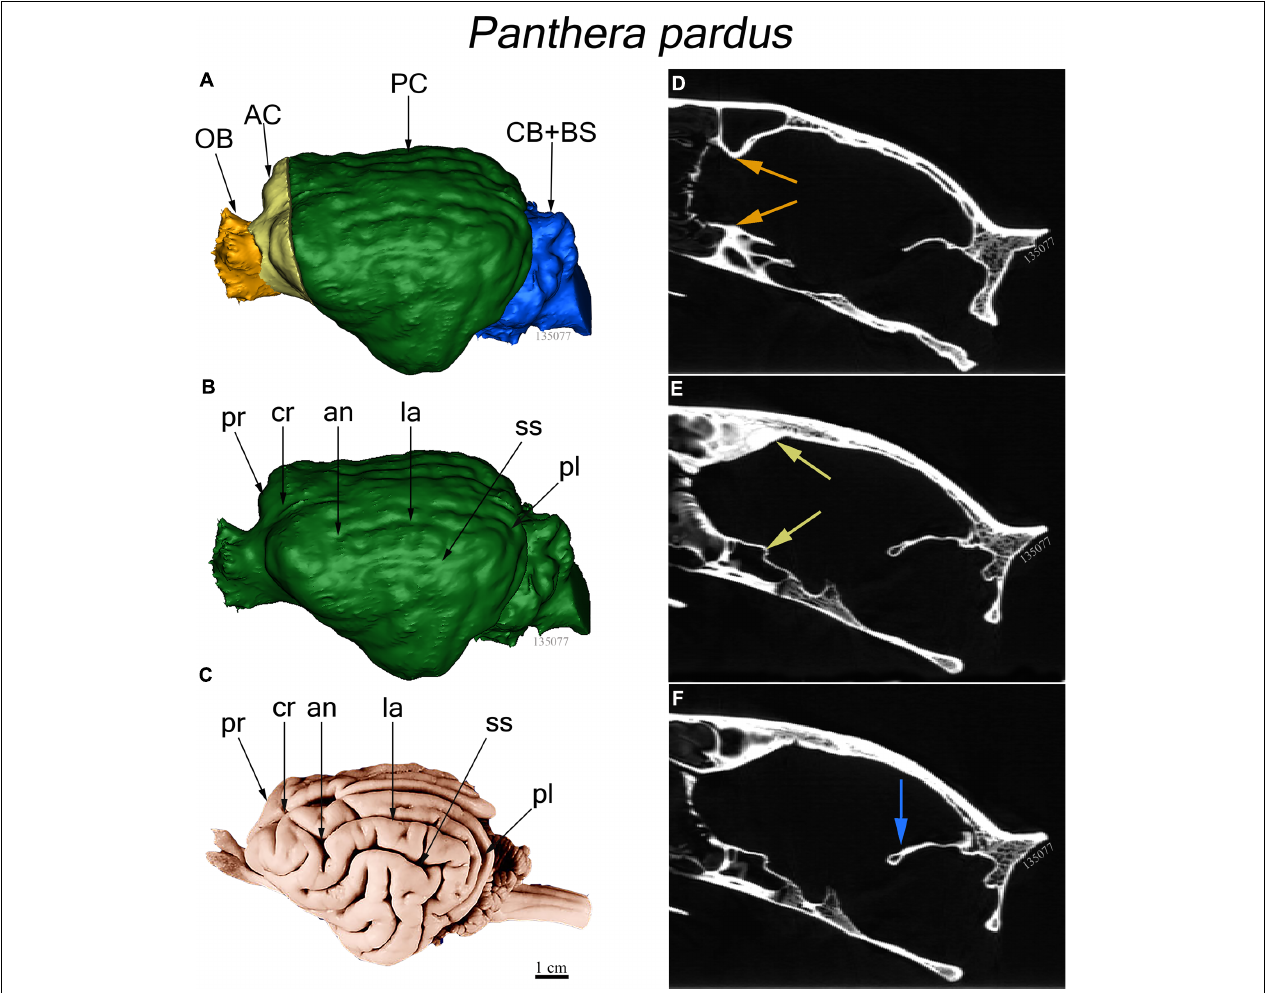
FIGURE 1 | (A–C) Three dimensional reconstructions of virtual endocasts from computed tomography (CT) scanned skull and whole brain view of the leopard ( Panthera pardus ). (A) Dorsolateral view of a virtual endocast (FMNH specimen 135077) showing the regional brain volumes: Olfactory bulb (OB) in gold, anterior cerebrum (AC) in yellow, posterior cerebrum (PC) in green, and cerebellum and brain stem (CB + BS) in blue. (B) Virtual endocast of the same specimen showing the prominent sulci. (C) Dorsolateral view of whole brain from the Comparative Mammalian Brain Collection. Abbreviations: an, ansate sulcus; cr, cruciate sulcus; pl, postlateral sulcus; la, lateral sulcus; pr, proreal sulcus; ss, suprasylvian sulcus. Scale bar = 1 cm. (D–F) Sagittal CT scans showing bony landmarks used to demarcate brain regions shown in (A) . (D) Arrows (gold) denote the narrow constriction that demarcates the caudal boundary of OB and the rostral edge of AC. (E) Arrows (yellow) indicate the cruciate sulcus at midline (dorsal) and optic canal (ventral), the boundary between caudal AC and rostral PC. (F) Arrow (blue) shows the cerebellar tentorium, the boundary separating the caudal PC from rostral CB +